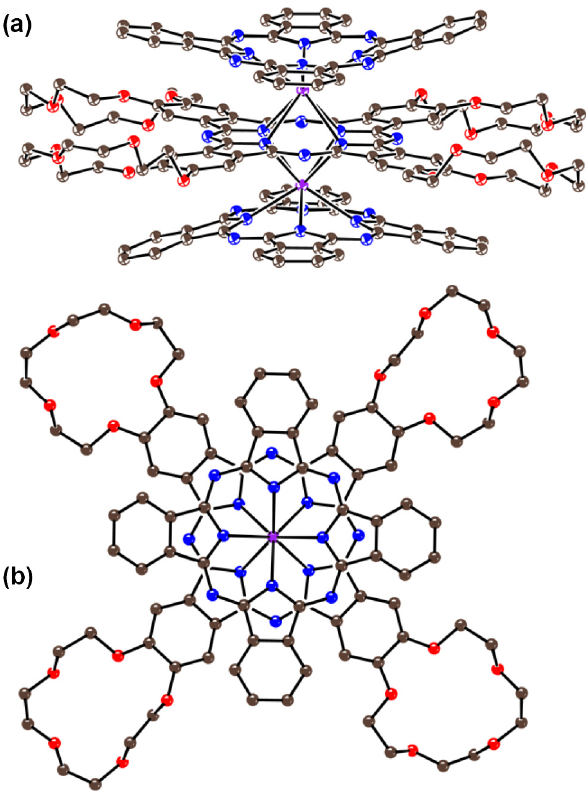
Figure 1. Molecular structure of triple-decker phthalocyanine—(Pc)Tb[(15C5) 4 Pc]Tb(Pc) · 6C 6 H 4 Cl 2 2— viewed approximately along the Pc planes ( a ) and along two terbium atoms ( b ).